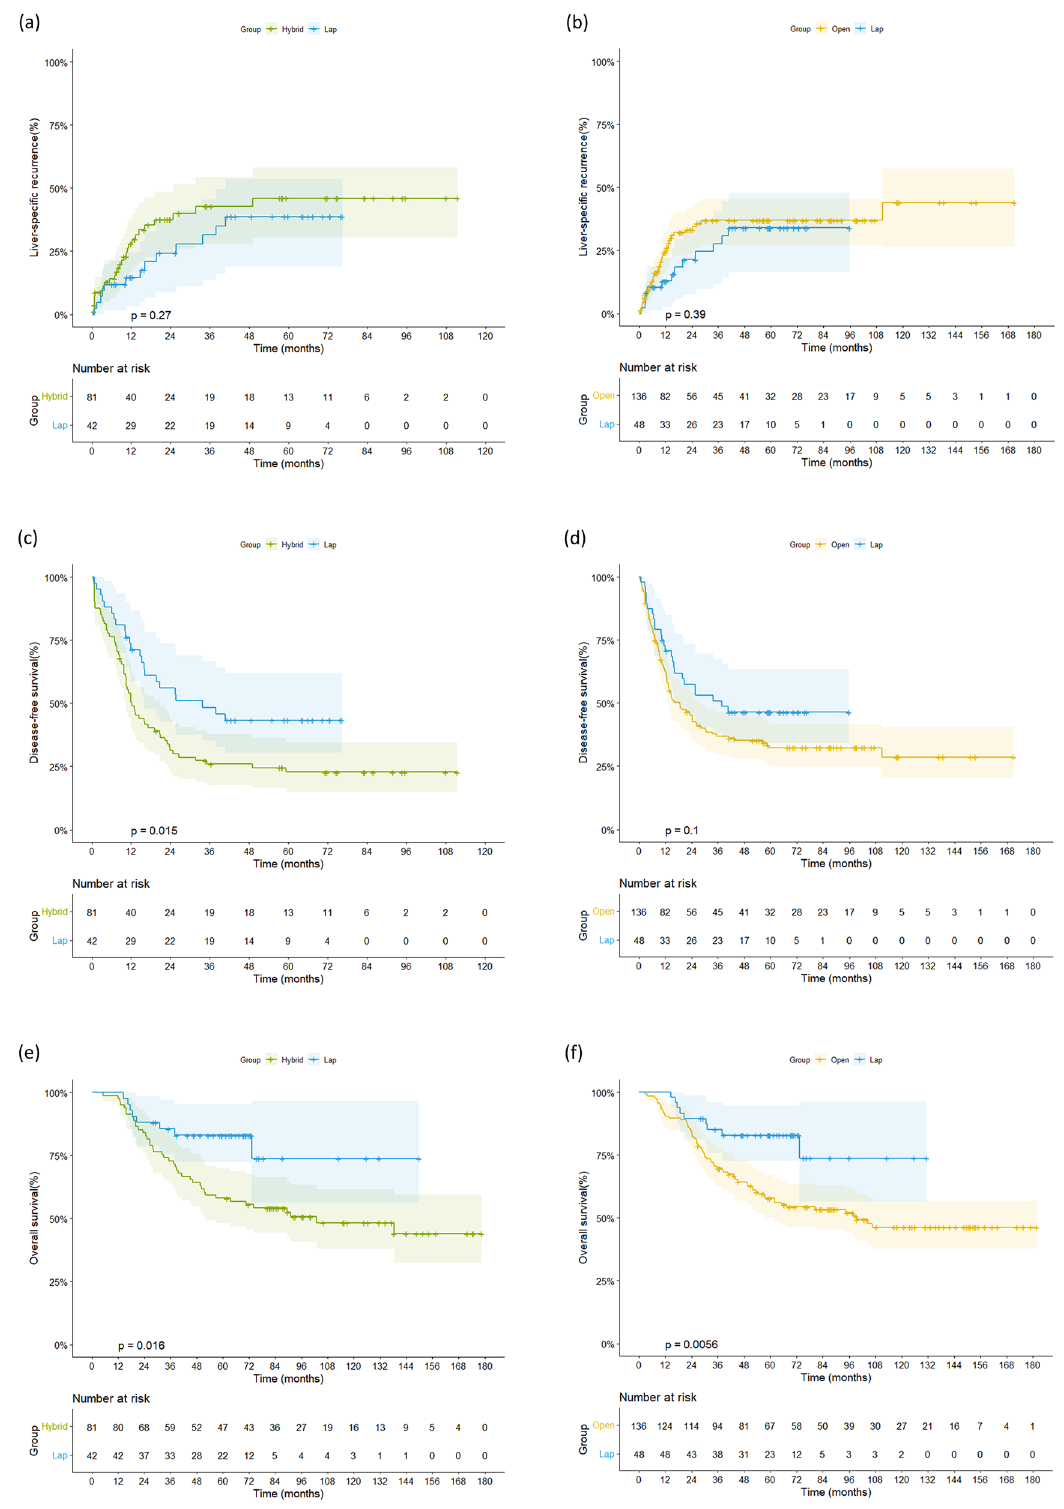
Figure 2. Kaplan–Meier curves of cumulative liver-specific recurrence rate, disease-free survival and overall survival according to treatment group after propensity score matching. The cumulative liver-specific recurrence rates were similar between ( a ) the laparoscopic group and hybrid group, and ( b ) the laparoscopic group and open group. ( c , d ) Disease-free survival and ( e , f ) overall survival were higher in the laparoscopic groups than in the hybrid group and the open group. Lap,